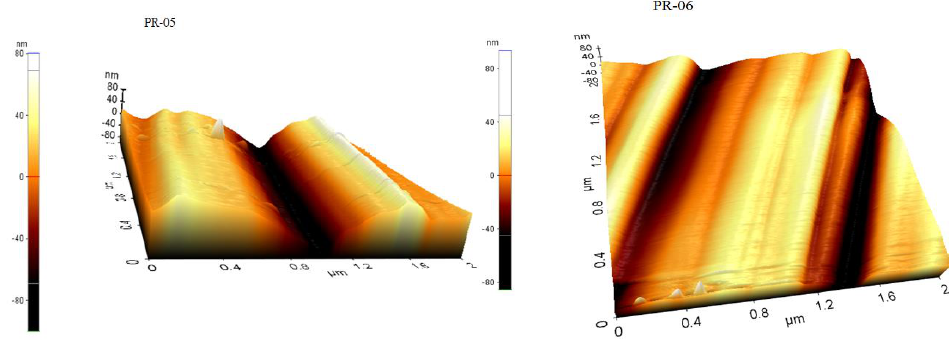
Figure 11. AFM images of blended PVDF membranes films prepared in NMP.